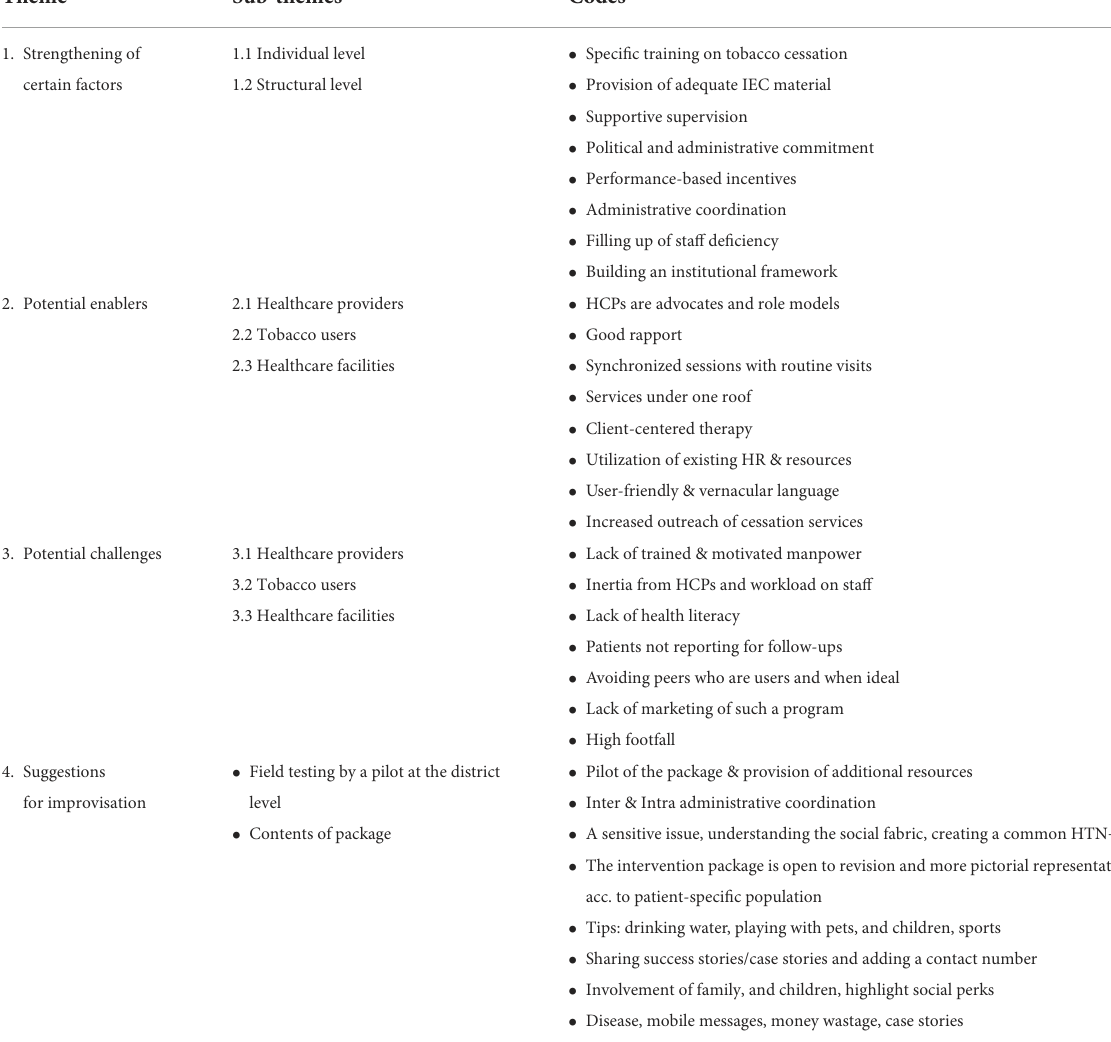
TABLE 5 Themes and codes as per thematic